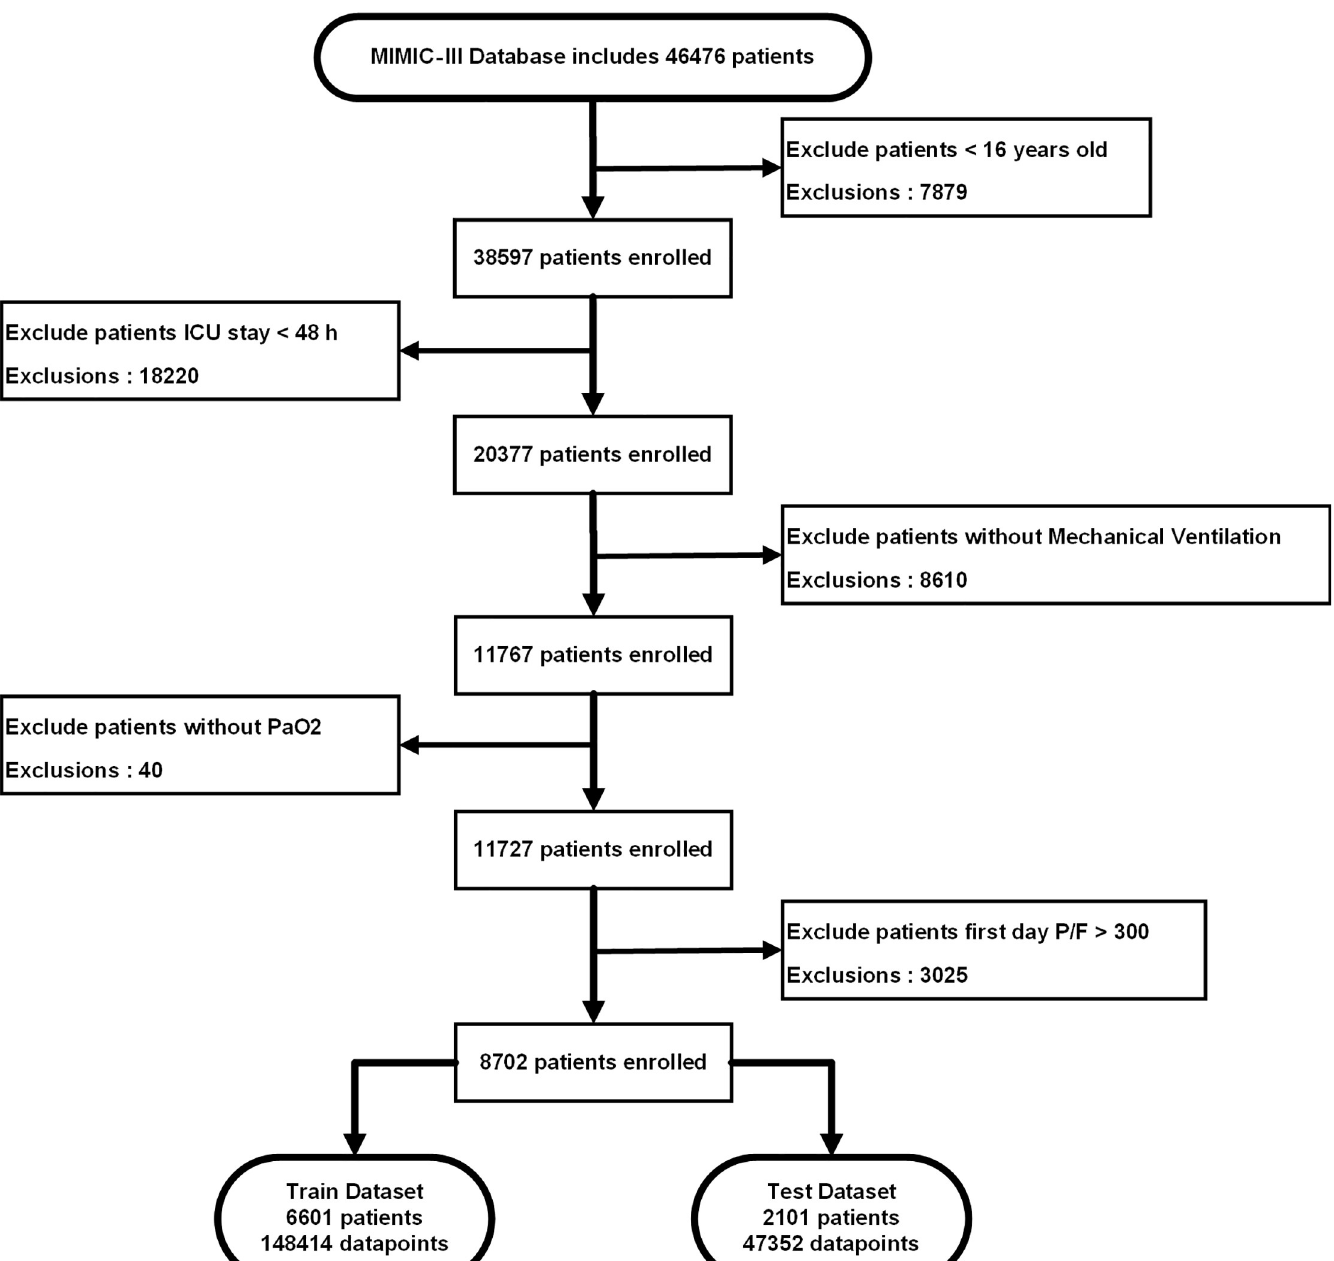
Fig 3. Flow diagram for patient selection. According to the ARDS diagnostic criteria, the appropriate enrolled population was selected from more than 40,000 patients in the MIMIC-III database, and 8702 eligible patients were finally included, and the data sets were randomly divided into training sets and test sets.